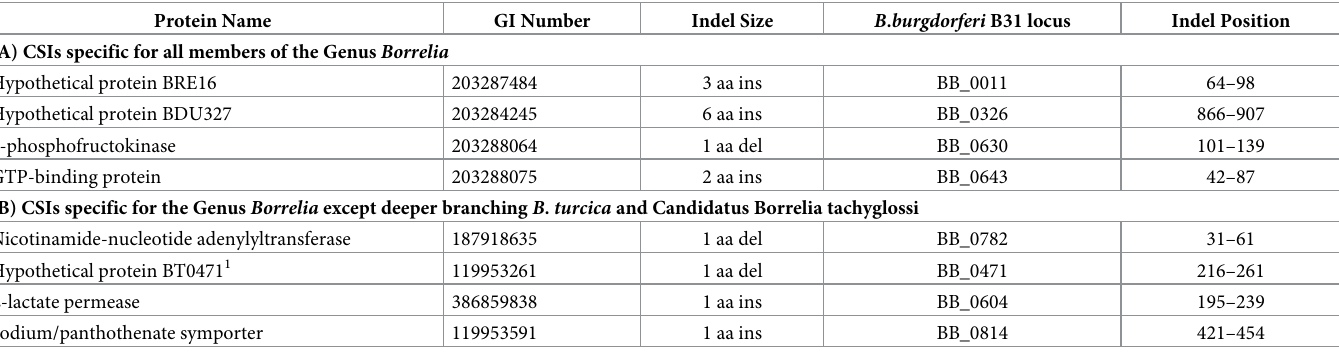
Table 2. Conserved signature indels in proteins that are specific for either all members of the Genus Borrelia or those lacking in the deeper branching Borrelia tur- cica and Candidatus Borrelia